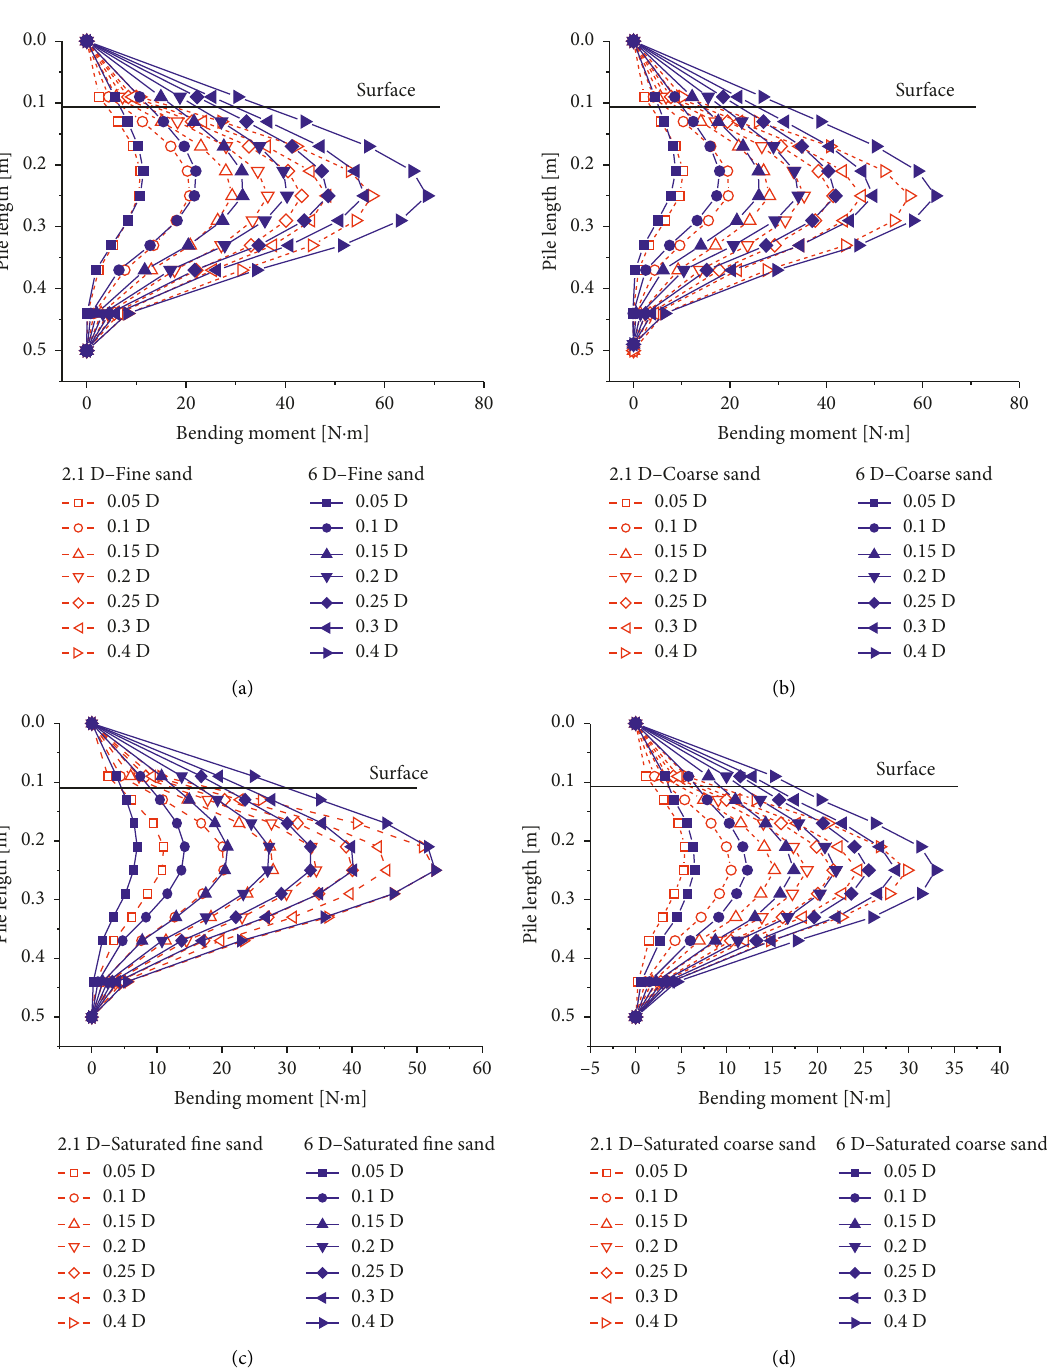
Figure 8: Comparisonofpilebendingmomentwithdifferentloadingheight.(a)Finesand,(b)coarsesand,(c)saturatedfinesand,and(d)saturated coarse